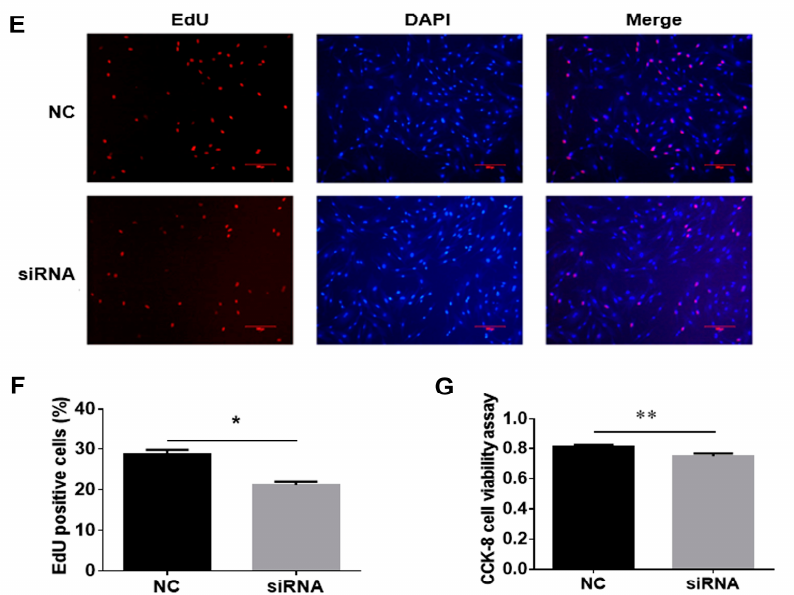
Figure 4. Knockdown of AQP3 inhibited the proliferation of porcine intramuscular adipocytes. Cells were transfected with AQP3 siRNA at 40%–50% confluence, and the interference effect was over 70% 24 h post-transfection ( A ). Cell cycle genes were analyzed by RT-qPCR ( B ) and Western blot ( C, D ). EdU staining was captured ( E ) and EdU-positive cells were counted to monitor the proliferation of cells ( F ). CCK-8 was adopted to check cell viability ( G ). n = 3. CDK4, cyclin-dependent kinase 4; PCNA, proliferating cell nuclear antigen; DAPI, 4 ′ ,6-diamidino-2-phenylindole ； * p < 0.05, ** p < 0.01.